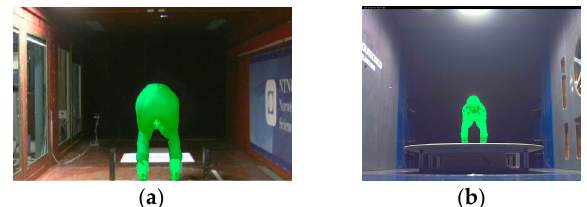
Figure 2. Rear ( a ) and front ( b ) images taken from the NTNU and PoliMi testing, respectively. These images were calibrated and used to calculate athlete frontal area.